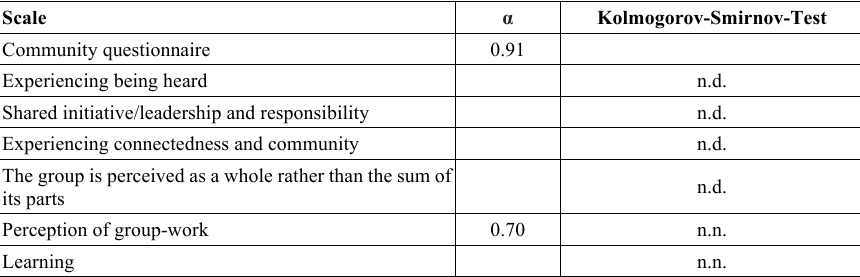
Table 3. Internal consistency through Cronbach’s